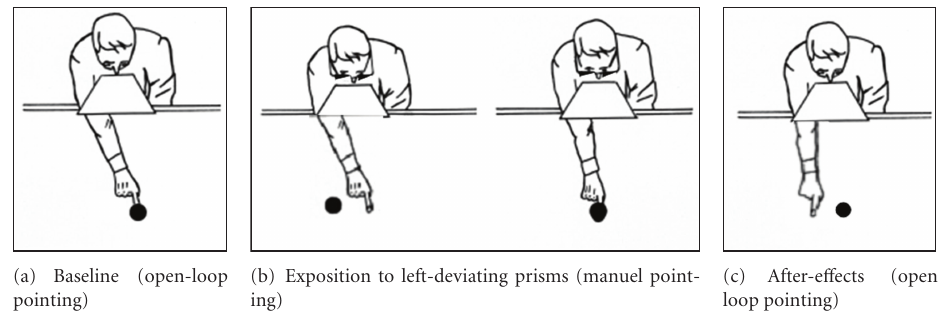
Figure 2: Left-deviating prism adaptation schematic